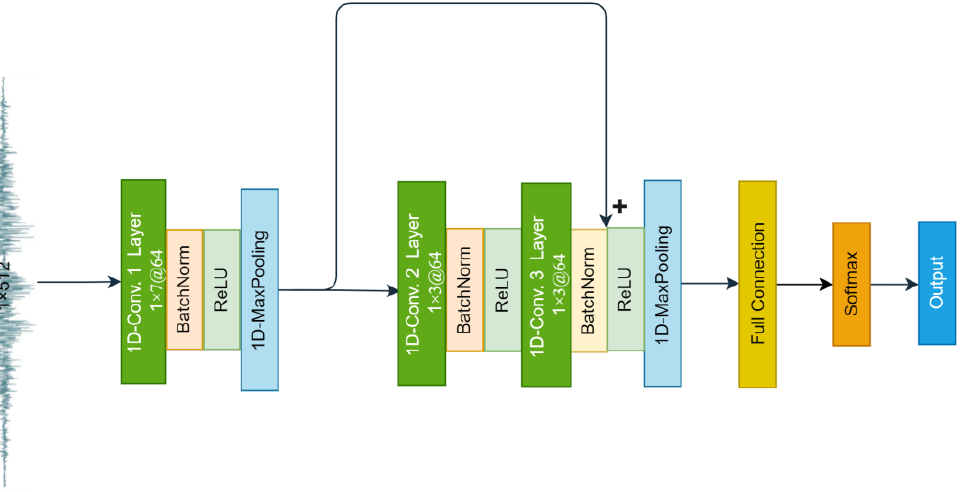
Figure 5. The 1D-RCNN network architecture for pavement roughness category